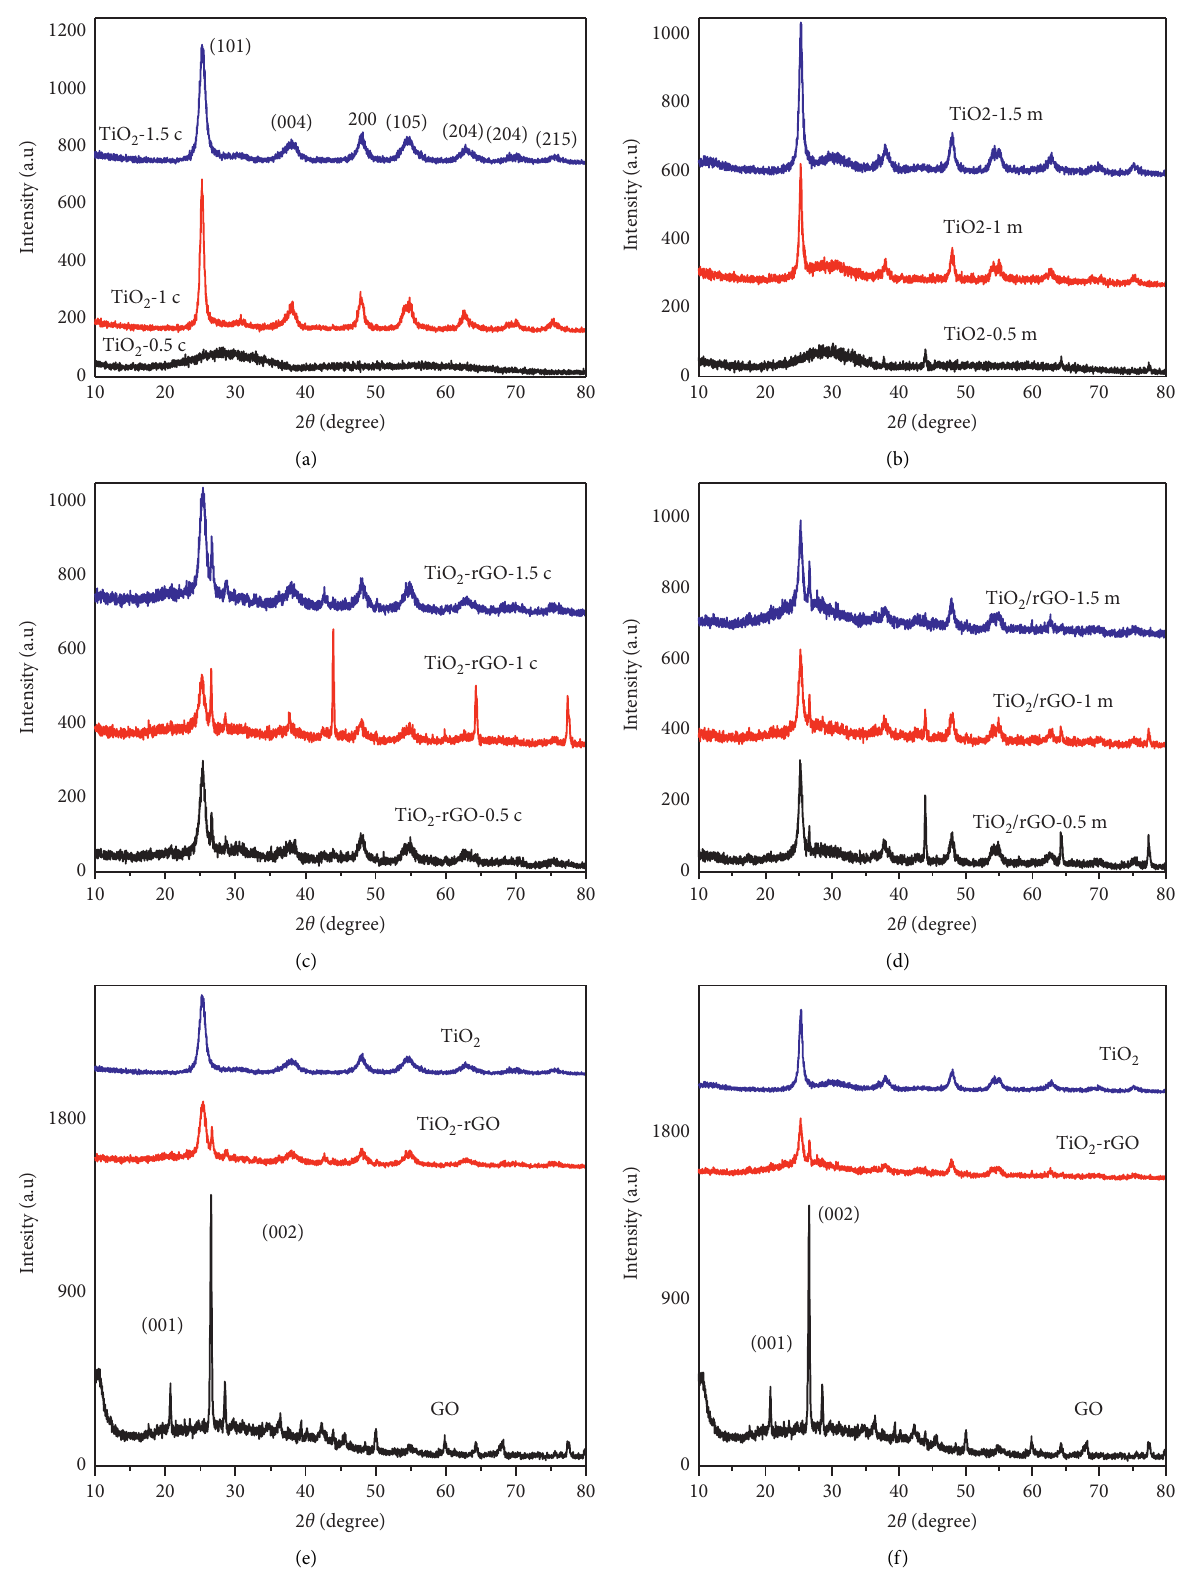
Figure 4: XRD spectra of (a) Citrus sinensis -TiO 2 NPs, (b) Musa acuminata -TiO 2 NPs, (c) Citrus sinensis -TiO 2 /rGO NCs, (d) Musa acuminata -TiO 2 /rGO NCs, (e) TiO 2 NPs, rGO c, and TiO 2 /rGO- Citrus sinensis NCs, and (f) TiO 2 NPs, rGO-m, and TiO 2 /rGO- Musa acuminata